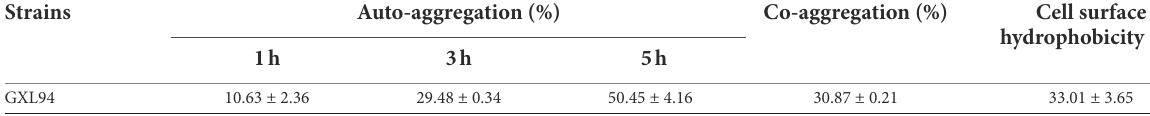
TABLE 4 Auto-aggregation, Co-aggregation and cell surface hydrophobicity of the LAB.